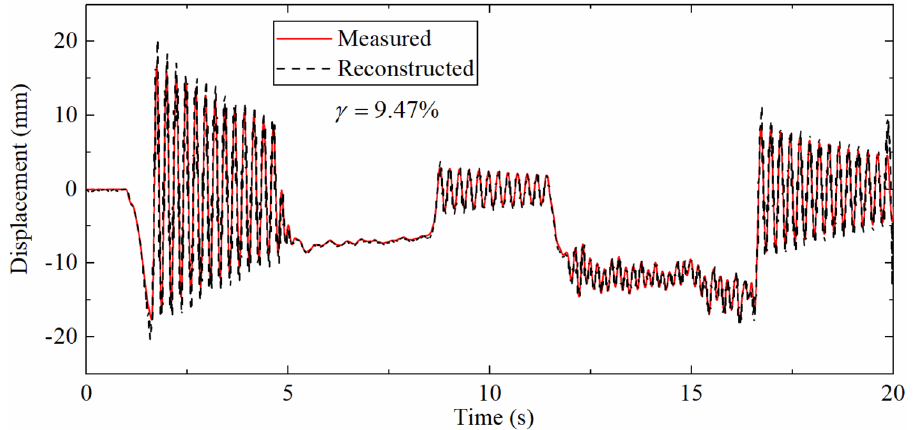
Figure 15. Displacement time history comparison (SRR is 40, DFF is 0.79 m).